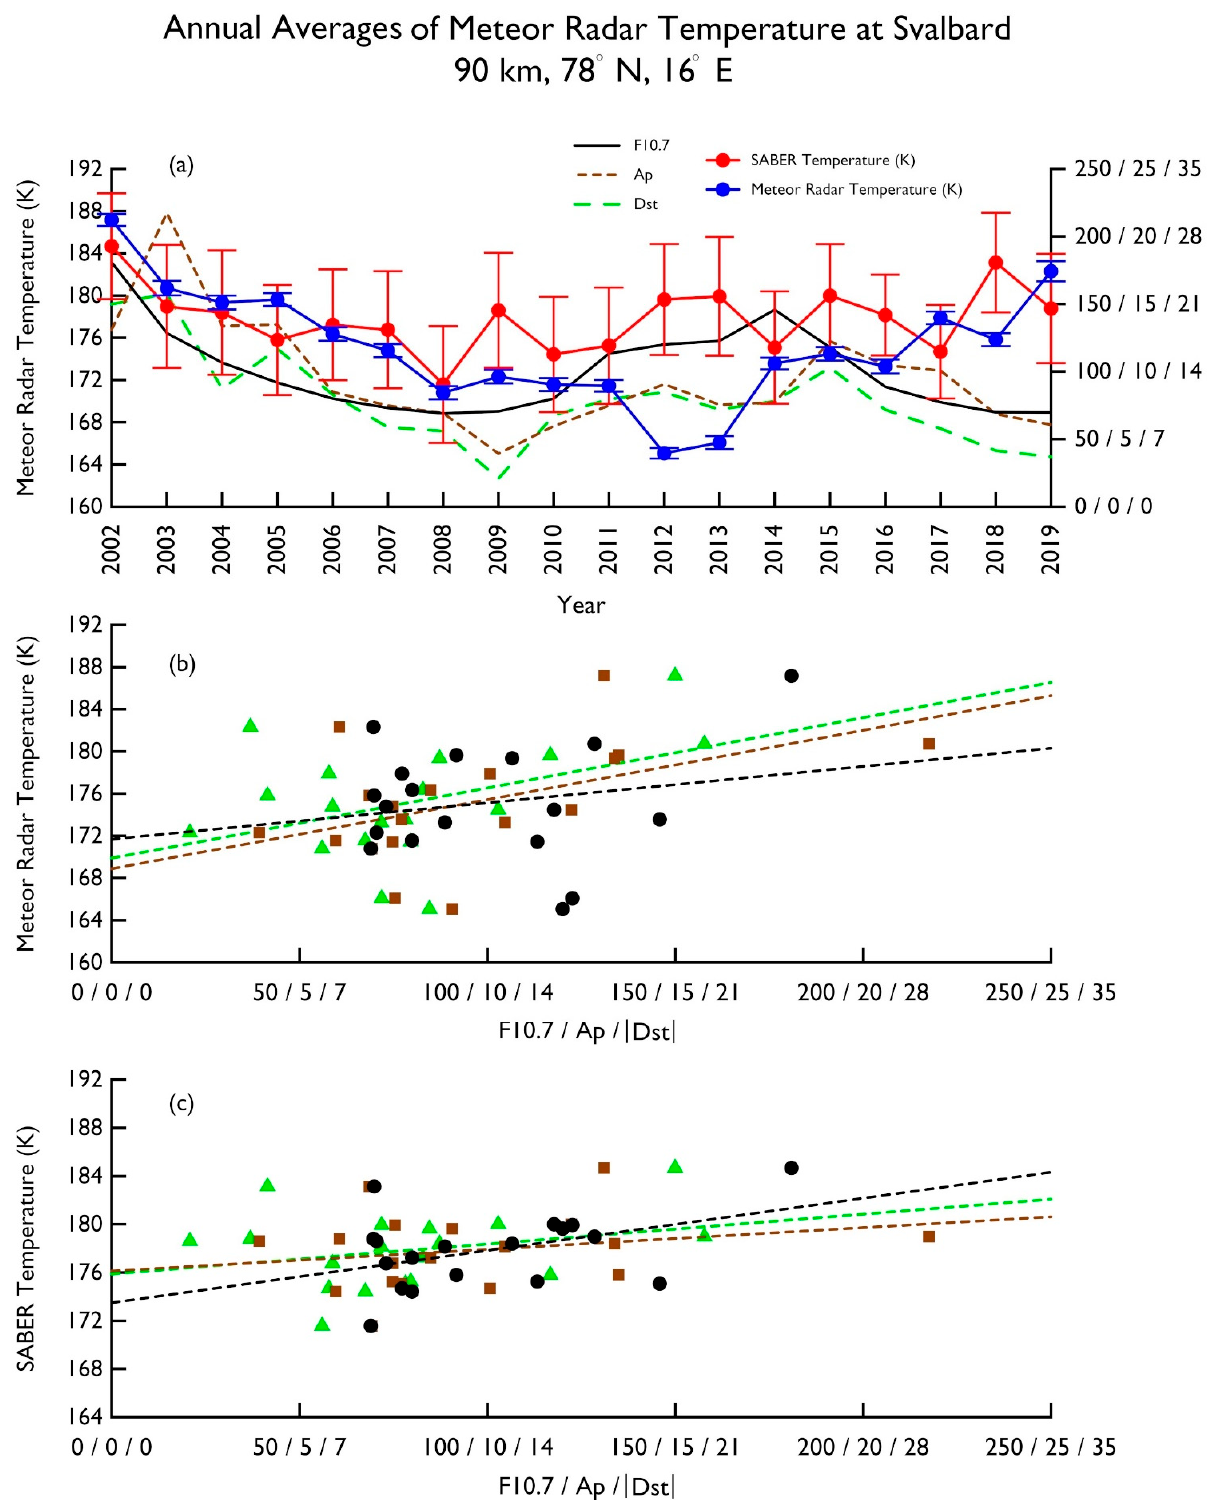
Figure 1. ( a ) Annual averages of meteor radar temperatures at Svalbard (blue line with dots) and annual averages of SABER temperatures (red line with dots) at the same location at 90 km altitude. The error bars show the range of uncertainties for the temperatures. Also plotted are annual averages for F10.7 (black line), Ap index (brown dashed line), and |Dst| index (green dashed line). ( b ) Svalbard temperatures plotted as a function of F10.7 (in black), Ap index (in brown), and |Dst| index (in green) with the respective trend lines. ( c ) SABER temperatures plotted as a function of F10.7, Ap index, and |Dst| index with the respective trend lines.